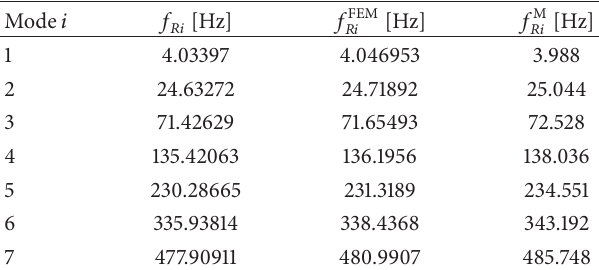
Table 10: Natural frequencies of the beam loaded by a stepped mass (scenario E).